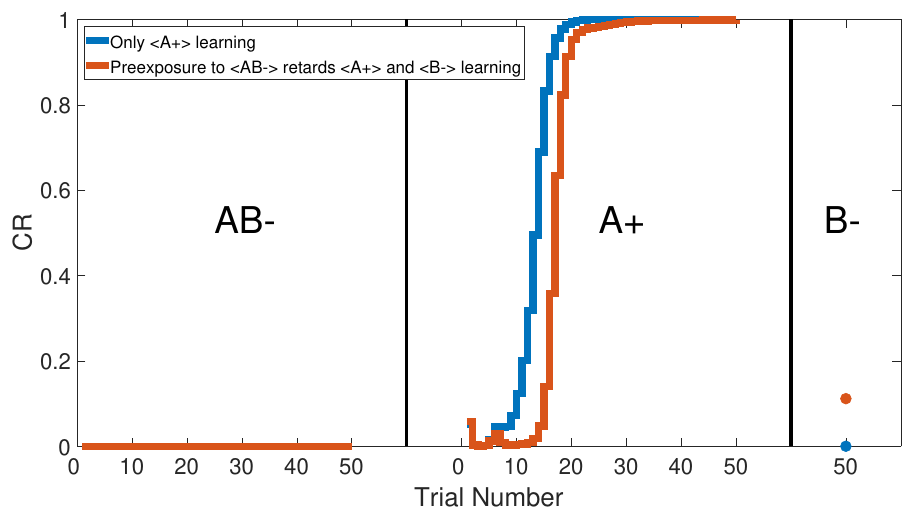
Figure 30. Two phases of compound preconditioning task for the intact system of CHCQ.